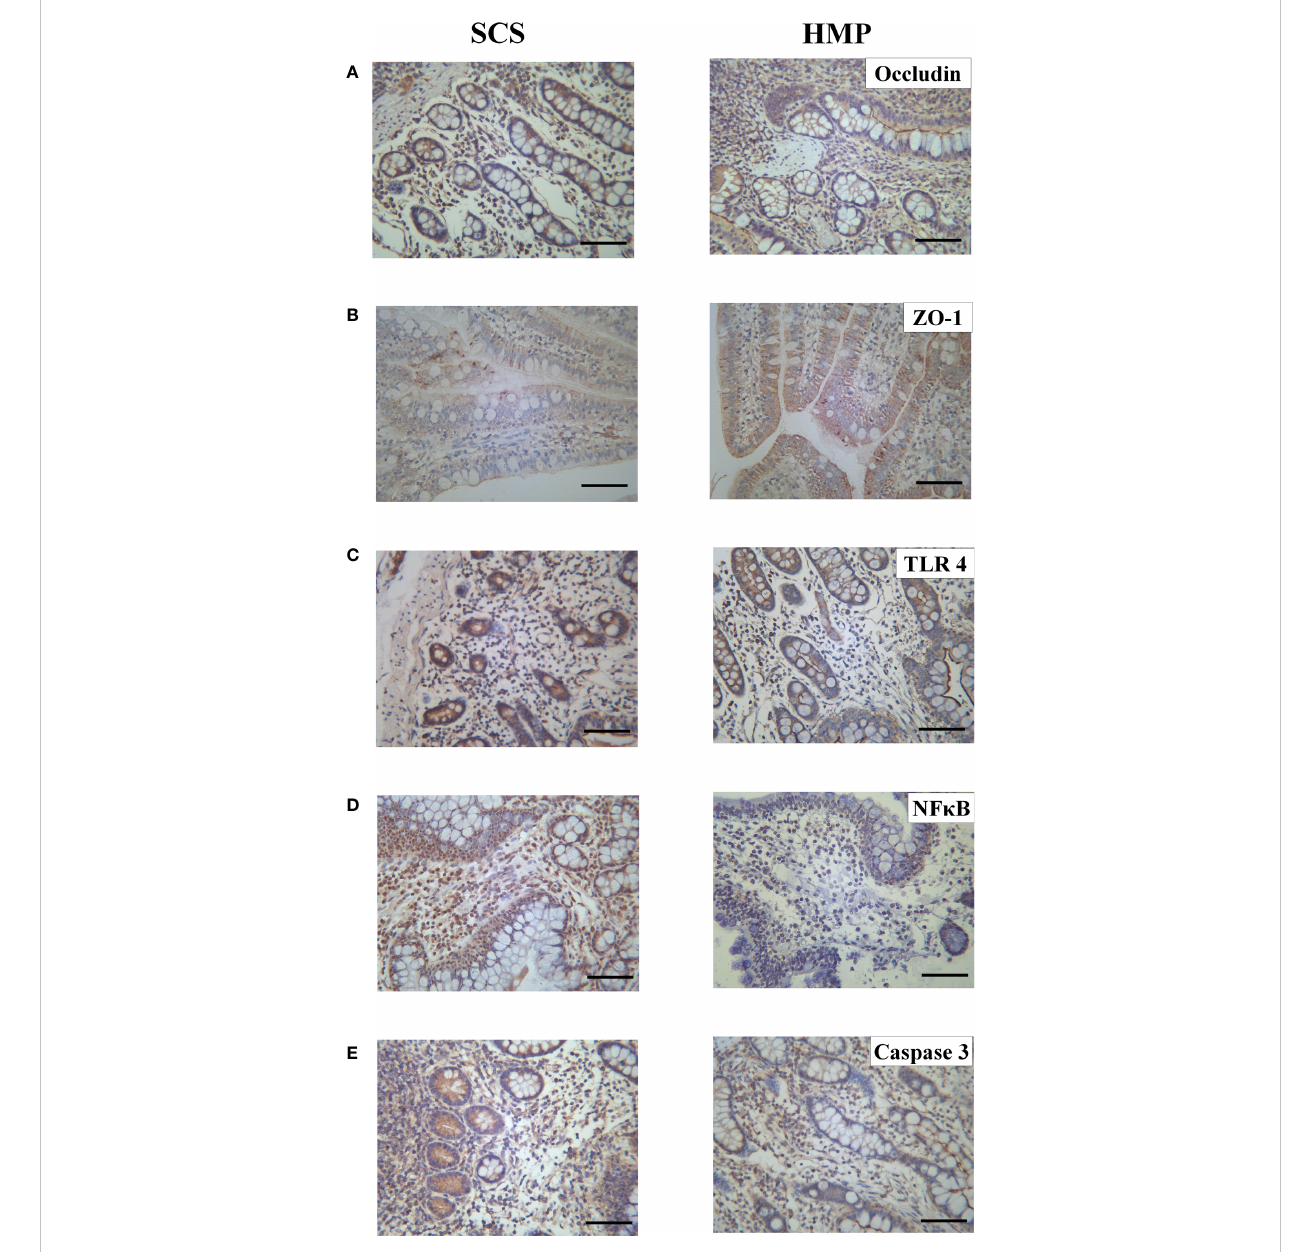
FIGURE 6 Expression levels of Occludin (A) ZO-1 (B) TLR4 (C) NF к B (D) and Caspase 3 (E) in intestinal tissues of the two groups by immunohistochemistry. (original magni fi cation, x200; scale bar, 100 m m;